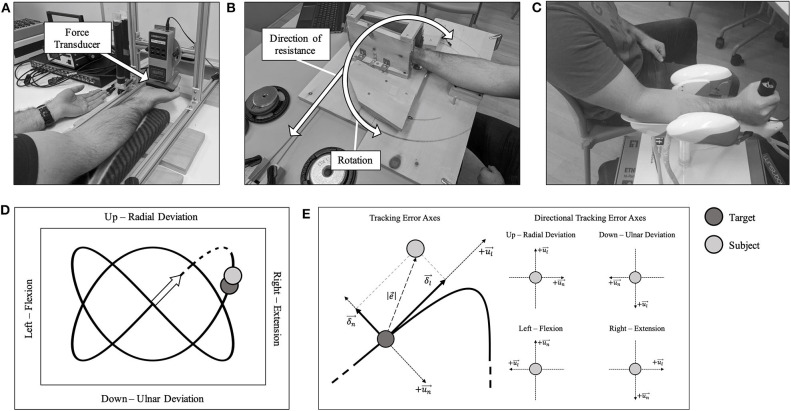
(A) Participants sat comfortably in front of the force transducer with their left-hand palm-up on the table. (B) Custom-made dynamic fatigue apparatus. (C) A participant seated with their forearm and hand placed in the WristBot. (D) A 2:3 Lissajous curve, which was visible during the hand-tracking. Movement directions are shown with their associated kinesiological action. The origin is shown as an arrow. The dashed portion of the curve was excluded from all analyses. (E) Left: the overall tracking error axes are shown. Right: the specific directional tracking error axes are shown. All components are with respect to the kinesiological action. The longitudinal axis is represented by +ul⃗, with its respective component represented by δl. The normal axis is represented by +un⃗, with its respective component represented by δn. The Euclidean distance between the subject's handle (H—light gray) and the target (T—dark gray) as |e⃗|.